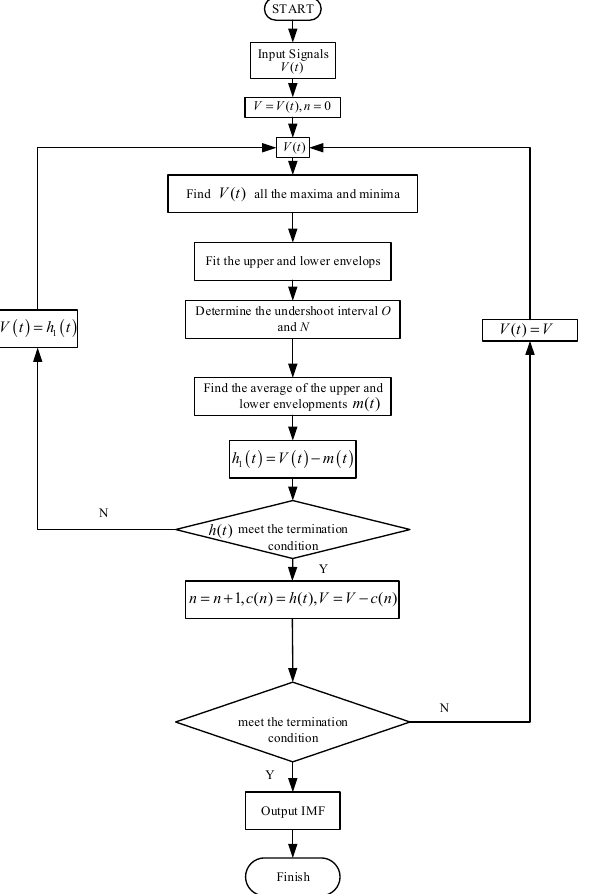
Figure 2. Flowchart of the improved empirical mode decomposition (IEMD) algorithm.